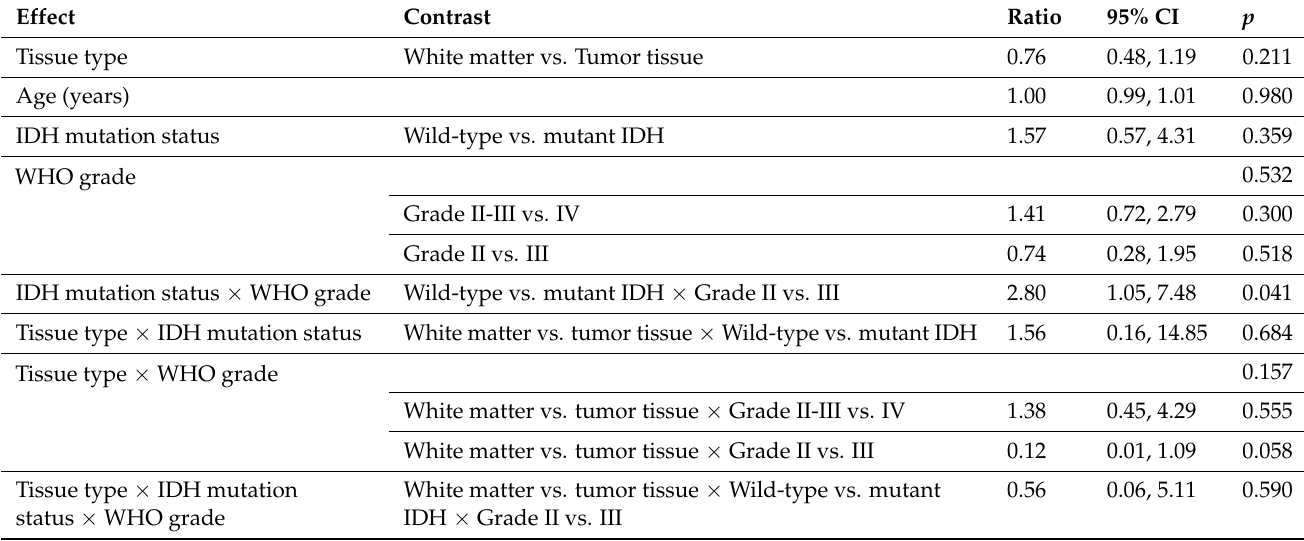
Table 2. Fixed effects in the linear mixed-effects model of the association between the elastic modulus and tumor character- istics (monotonic indentation